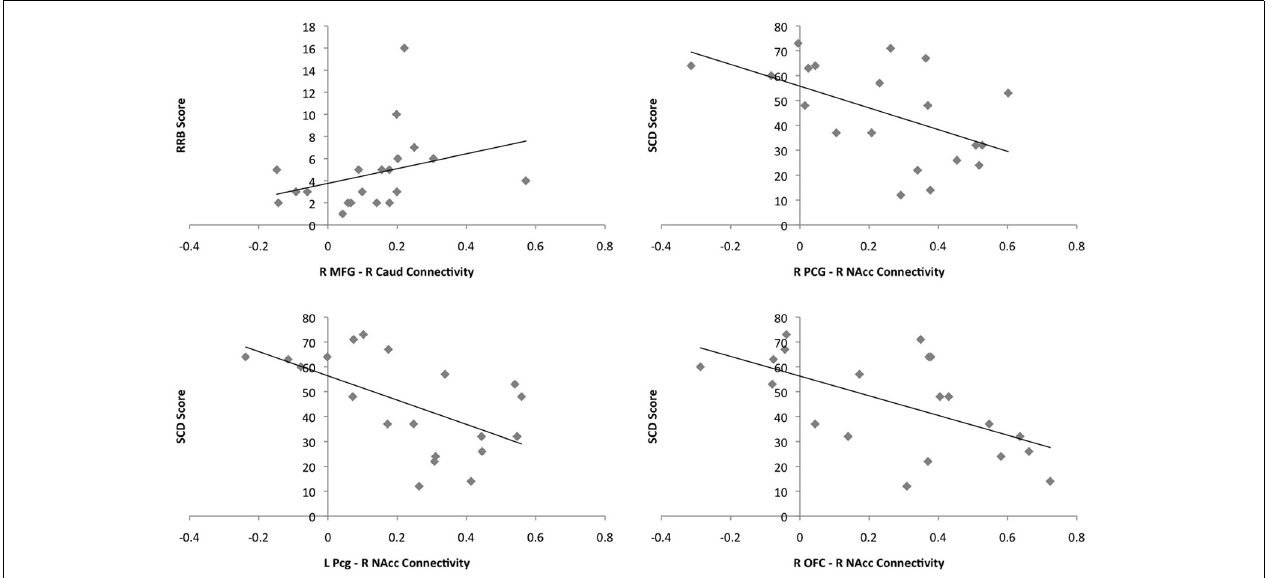
FIGURE 7 | Plots of the correlations between connectivity values and behavioral measures for the ASD group. Connectivity values are shown on the x-axes and scores on the behavioral measures on the y-axes. ASD single subjects are represented as gray diamonds (solid black trend-line).